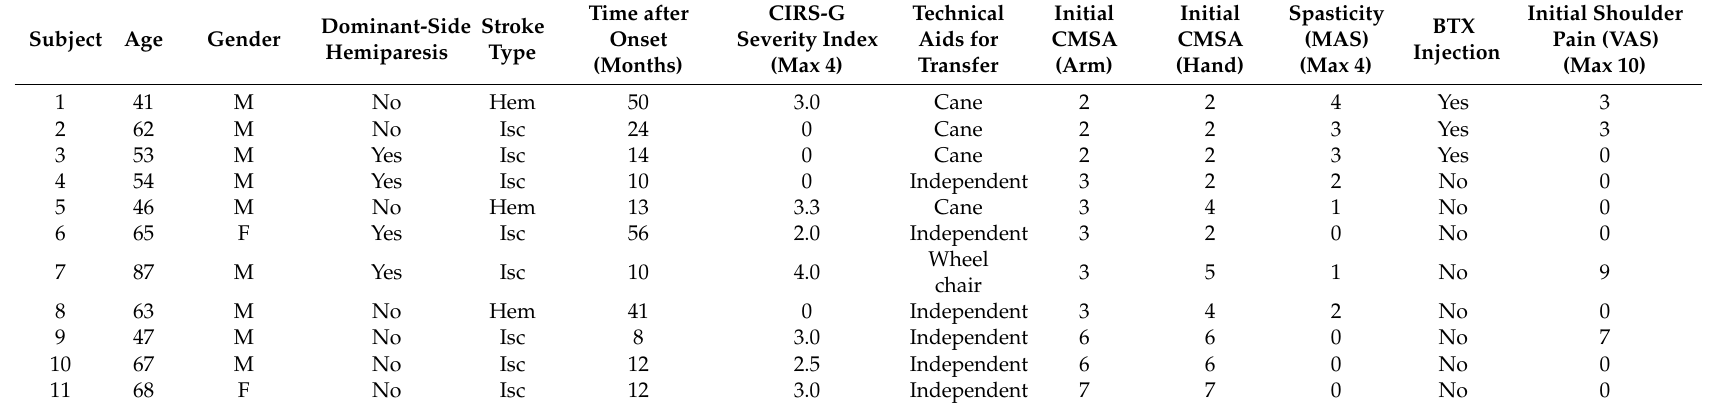
Table 1. Demographic and clinical characteristics of